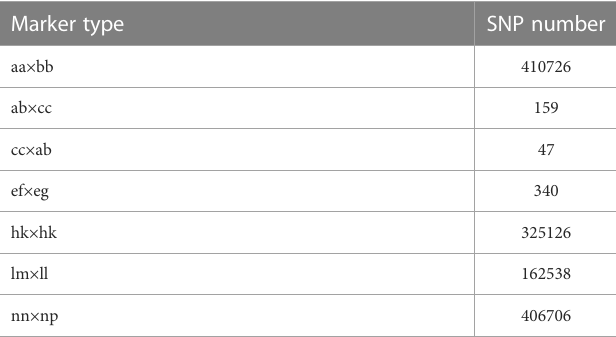
TABLE 3 Parent marker types and the number of